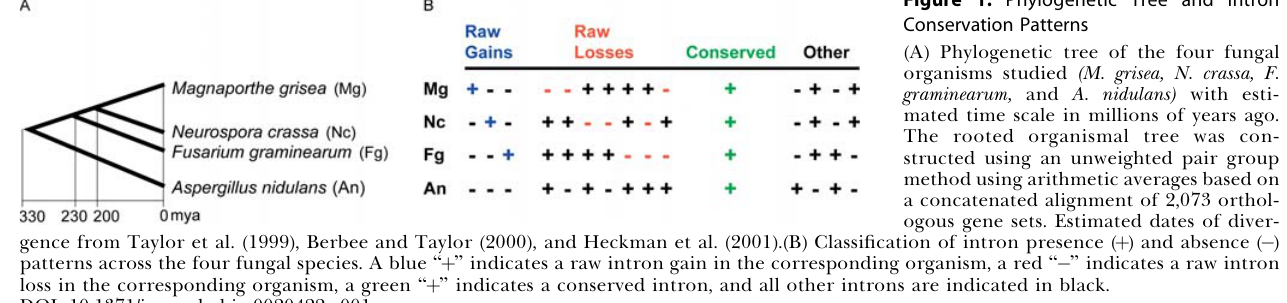
Figure 1. Phylogenetic Tree and Intron Conservation Patterns (A) Phylogenetic tree of the four fungal organisms studied (M. grisea, N. crassa, F. graminearum, and A. nidulans) with esti- mated time scale in millions of years ago. The rooted organismal tree was con- structed using an unweighted pair group method using arithmetic averages based on a concatenated alignment of 2,073 orthol- ogous gene sets. Estimated dates of diver-